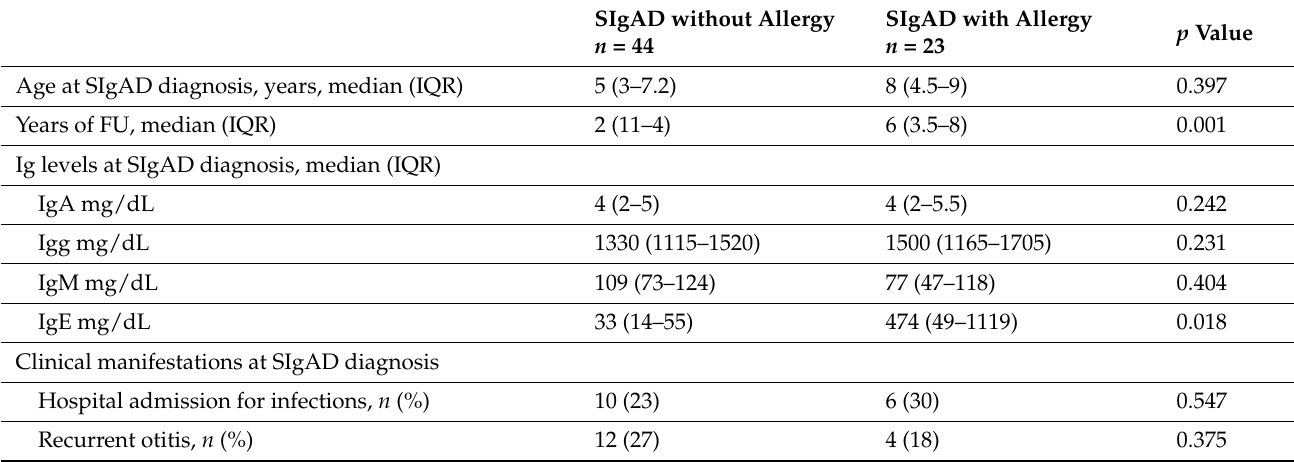
Table 5. Clinical and immunological features of SIgAD children and adolescents grouped according to the allergy diagnosis at the last